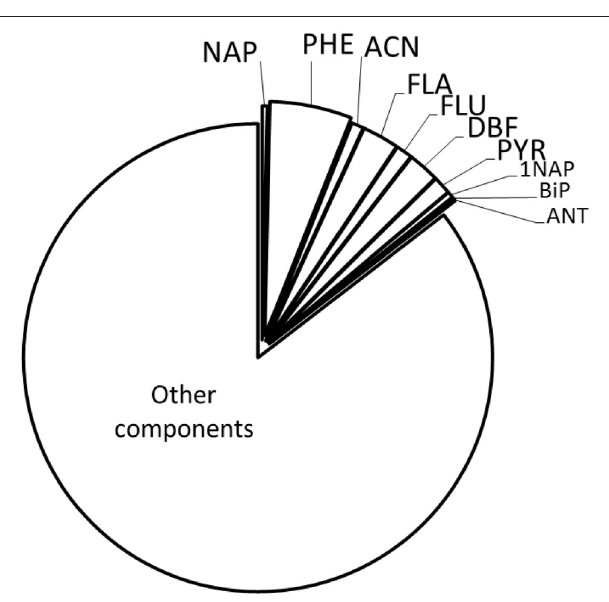
FIGURE 5 | Molar composition (f interface,calc ) or selectivity for PAH solubilisation of a theoretical film at the DNAPL/water interface, based on Table 1. “Other components” were not incorporated into the